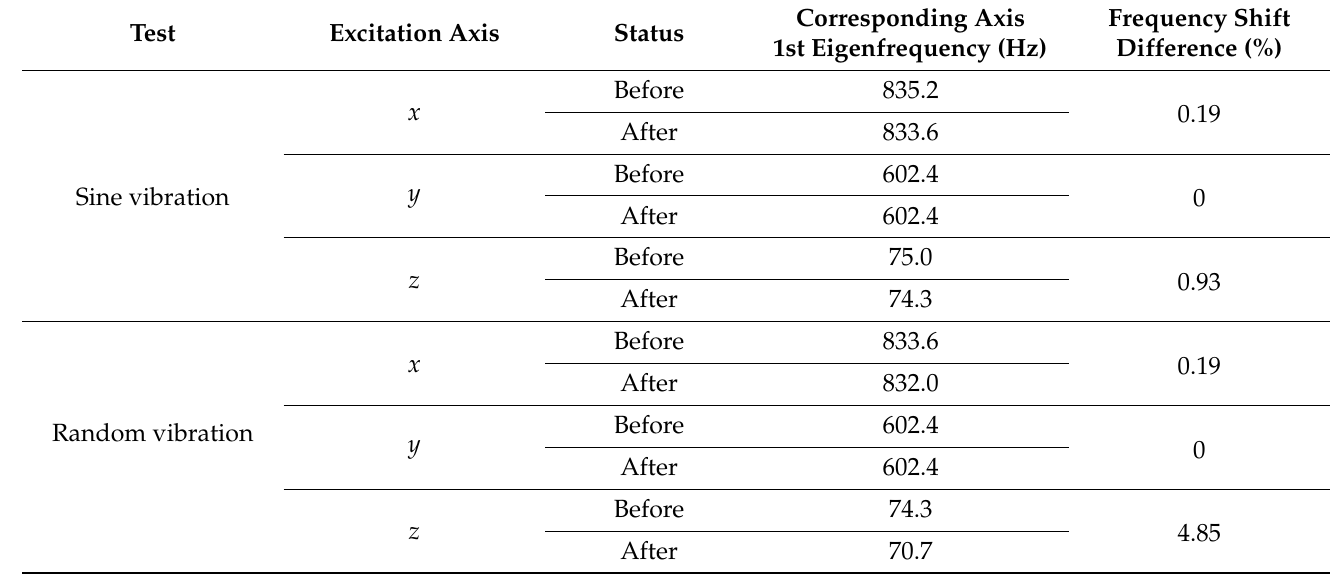
Table 8. Results of the VMLSA’s low-level sine sweep (LLSS) tests conducted before and after full-level vibration